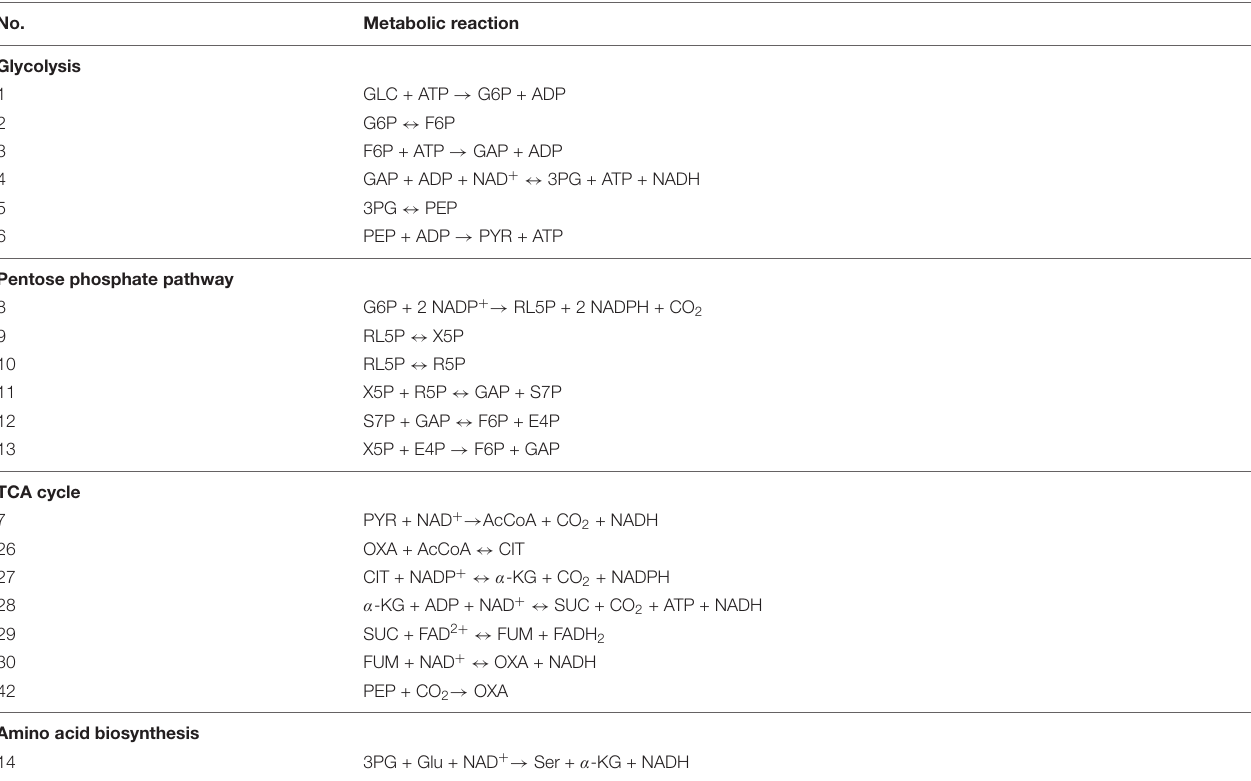
TABLE 1 | The metabolic reaction of the engineered E. coli W3110-BL. No. Metabolic